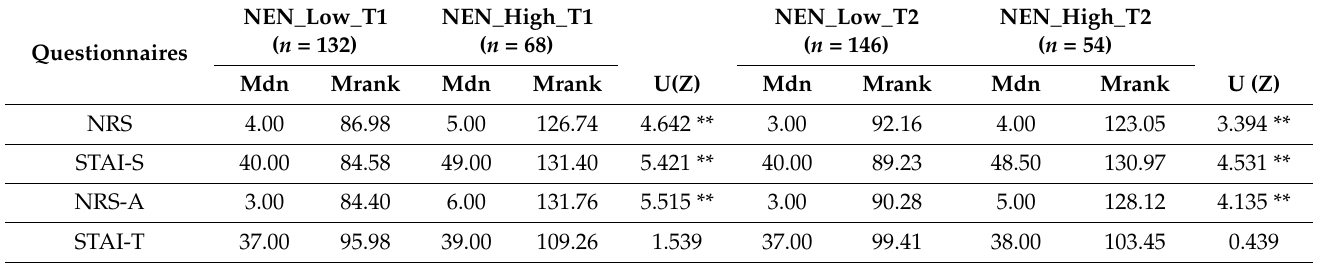
Table 3. Comparison of pain and anxiety of women in relation to the experienced need to entrust the newborn under the care of staff.